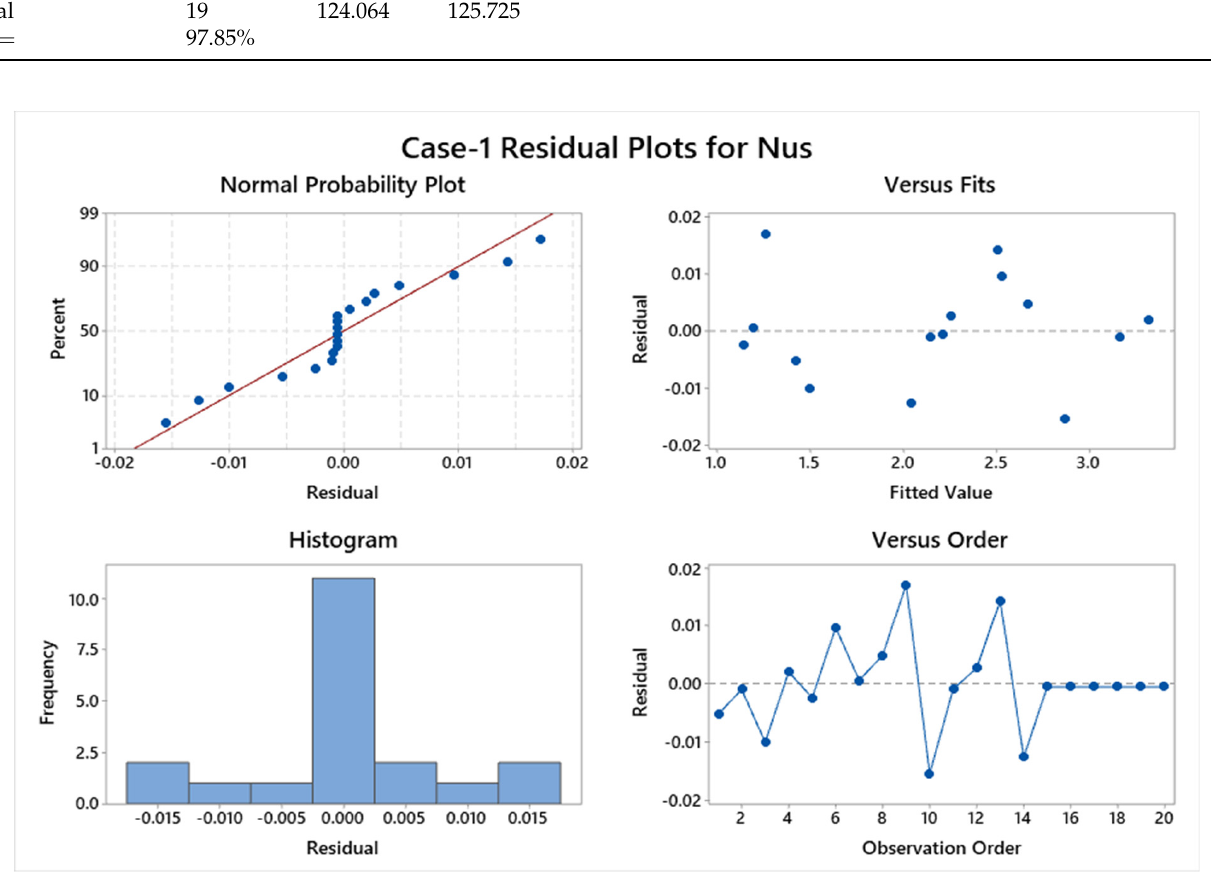
Figure 17. Case-1 Residual plots for Nusselt number.